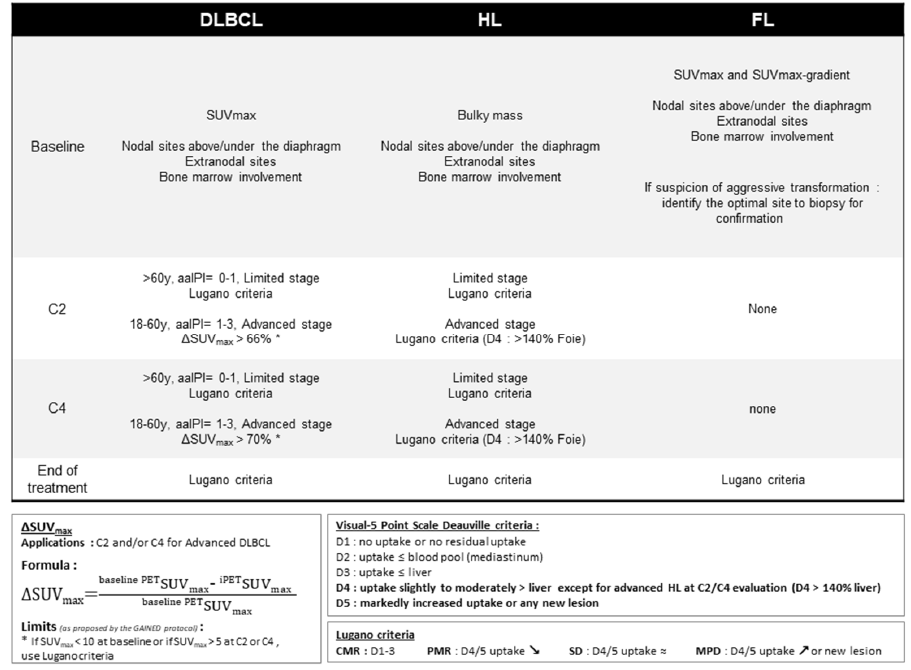
Figure 1. FDG-PET/CT criteria for staging and response assessment in lymphoma (aaIPI: age- Figure 1. FDG ‐ PET/CT criteria for staging and response assessment in lymphoma (aaIPI: age ‐ adjusted International Prog ‐ adjusted International Prognostic Index; C2: after 2 cycles of chemotherapy; C4: after 4 cycles of nostic Index; C2: after 2 cycles of chemotherapy; C4: after 4 cycles of chemotherapy; DLBCL: diffuse large B ‐ cell lym ‐ chemotherapy; DLBCL: diffuse large B-cell lymphoma; FL: follicular lymphoma; HL: Hodgkin phoma; FL: follicular lymphoma; HL: Hodgkin lymphoma; SUVmax: maximum standard uptake value). lymphoma; SUVmax: maximum standard uptake